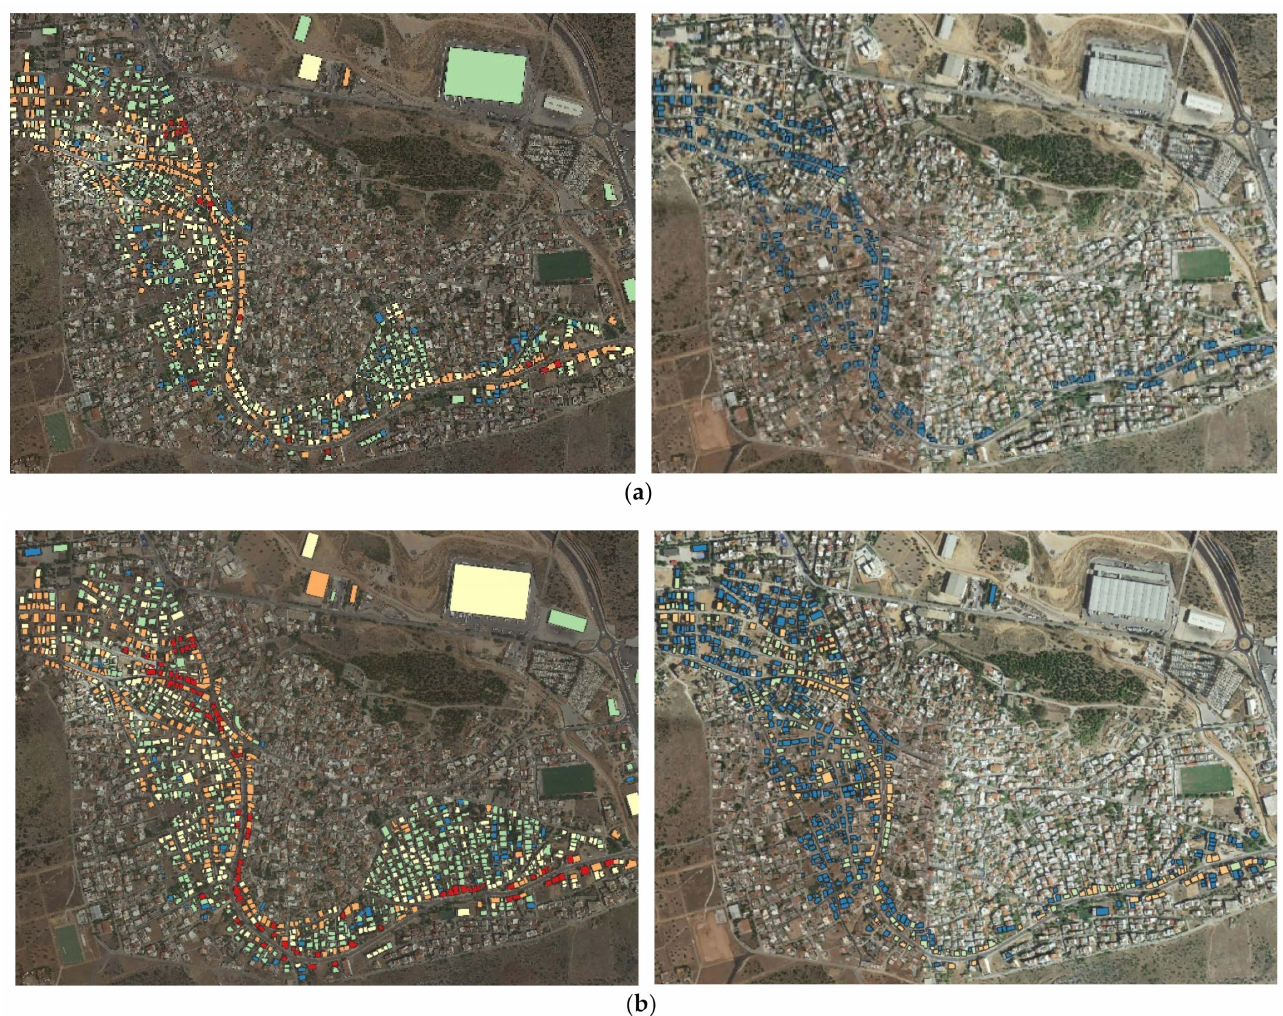
Figure 9. Flood hazard (H) in the residential area for 4 indicative scenarios: ( a ) Scenarios S20-06 ( left ) and W20-06 ( right ) for T = 20 y and t = 6 h. ( b ) Scenarios S200-18 ( left ) and W200-18 ( right ) for T = 200 y and t = 18